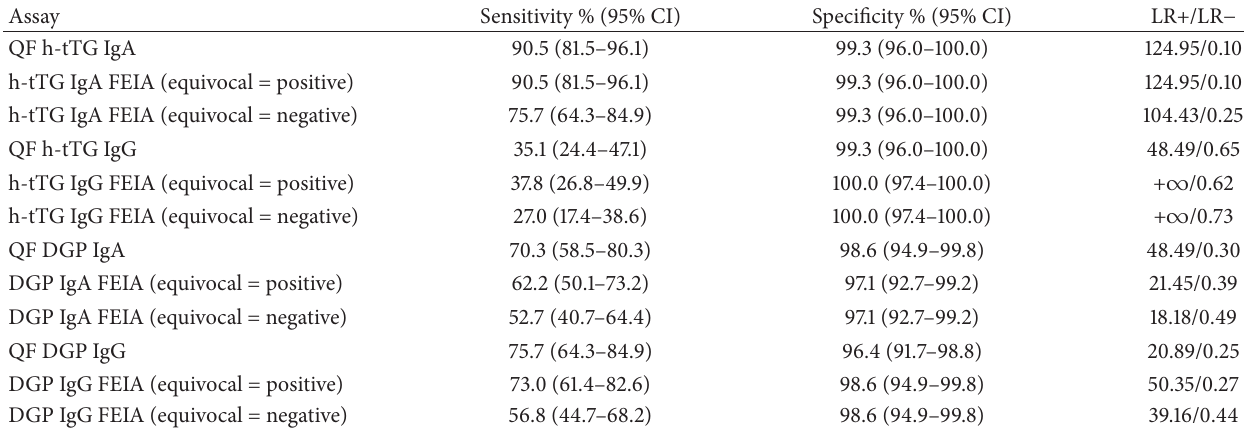
Table 2: Clinical sensitivity and